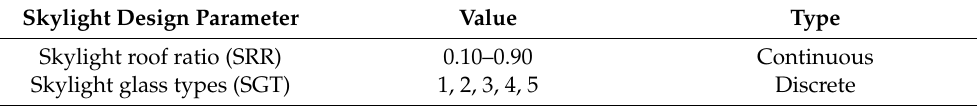
Table 4. Skylight design parameters.